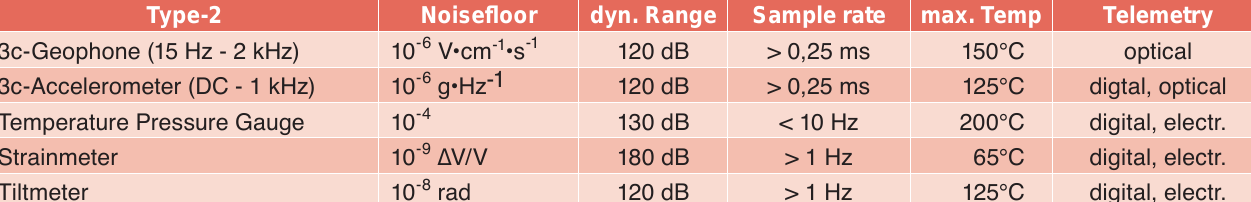
Table 2: A selection of commercially available sensor systems for the Type-2 permanent downhole monitoring